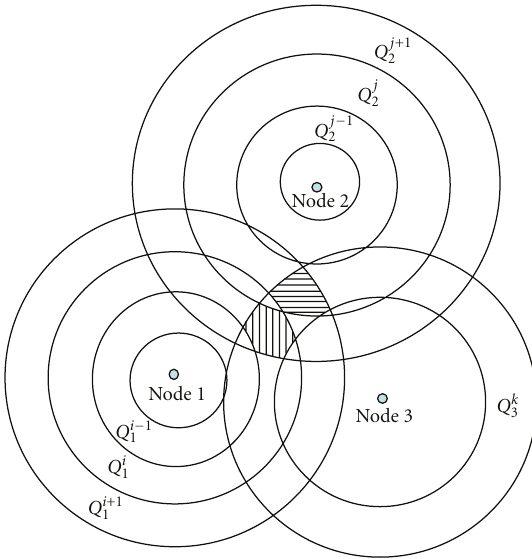
Figure 2: Simple example of source localization, where an acoustic amplitude sensor is employed at each node. The shaded regions refer to nonempty intersections, where the source can be